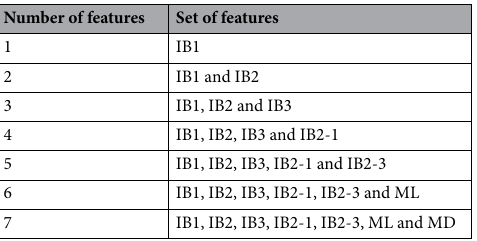
Table 4. S et of features used for adjusted R 2 value calculation.